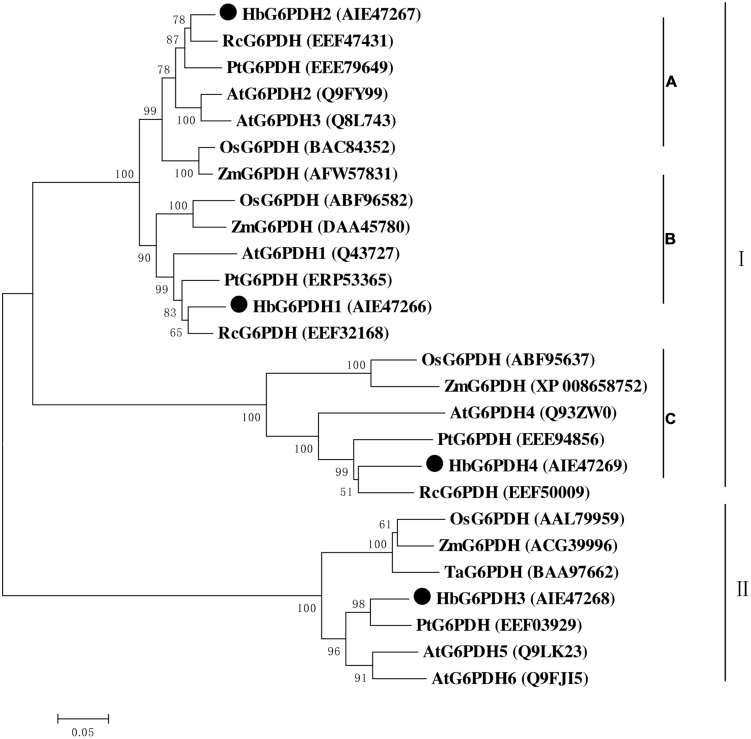
Phylogenetic analysis of 26 plant glucose-6-phosphate dehydrogenase (G6PDH) isoforms from public databases. The unrooted phylogenetic tree of 26 G6PDH proteins including 4 H. brasiliensis G6PDHs was constructed using the neighbor-joining method in the MEGA 5.05 program. Except the H. brasiliensis, the six other plant species are Populus trichocarpa, Ricinus communis, Arabidopsis thaliana, Zea mays, Oryza sativa, and Triticum aestivum. The group I were divided into three clusters (A–C).